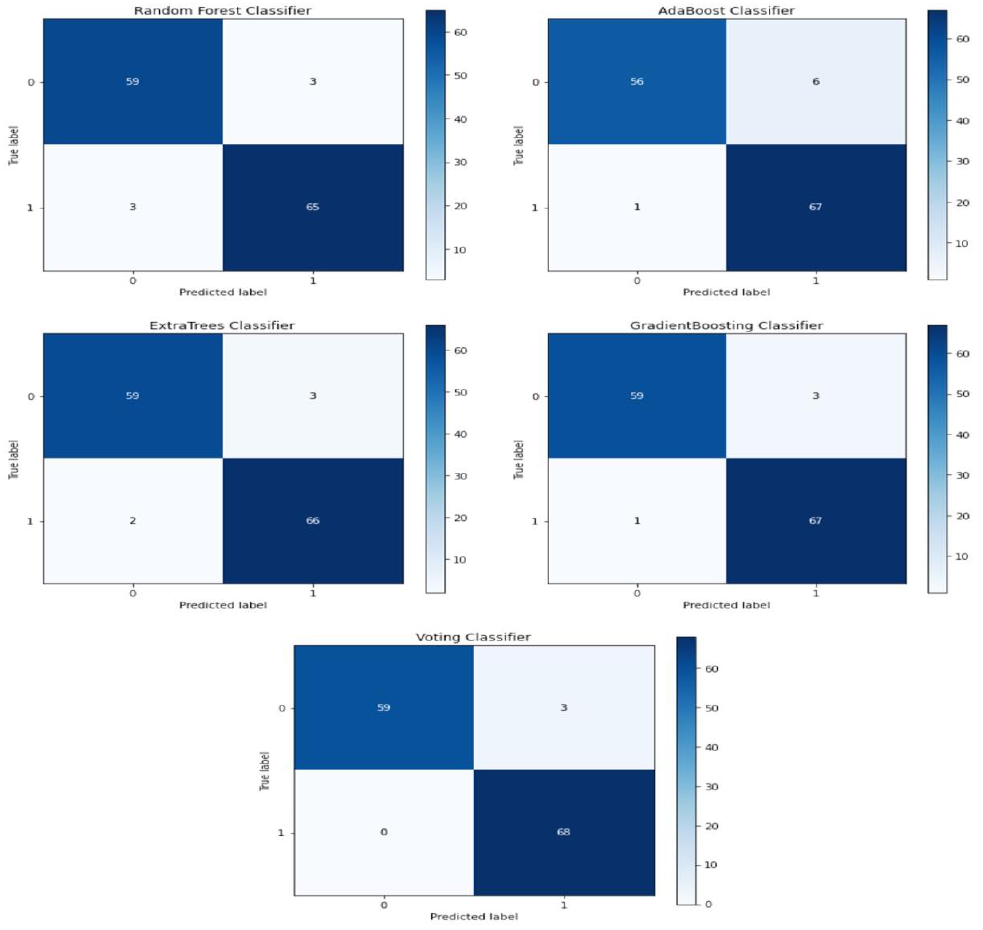
Figure 4. Confusion matrix with all proposed ML models.